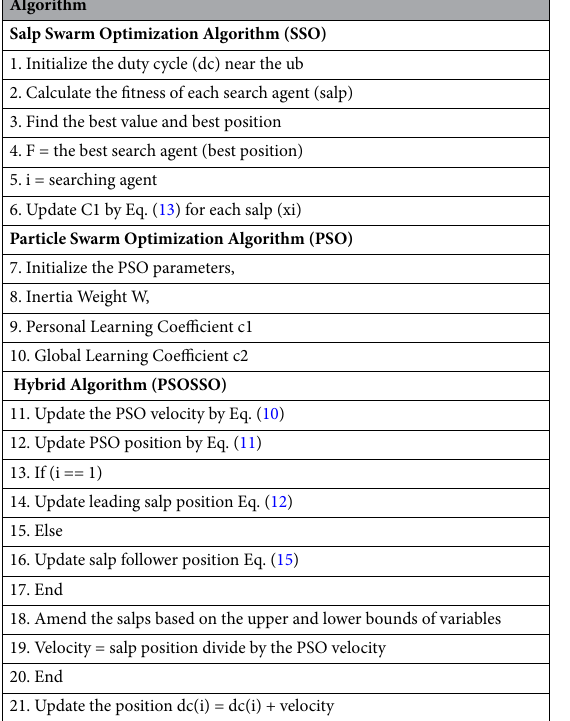
Table 1. Proposed PSOSSO algorithm